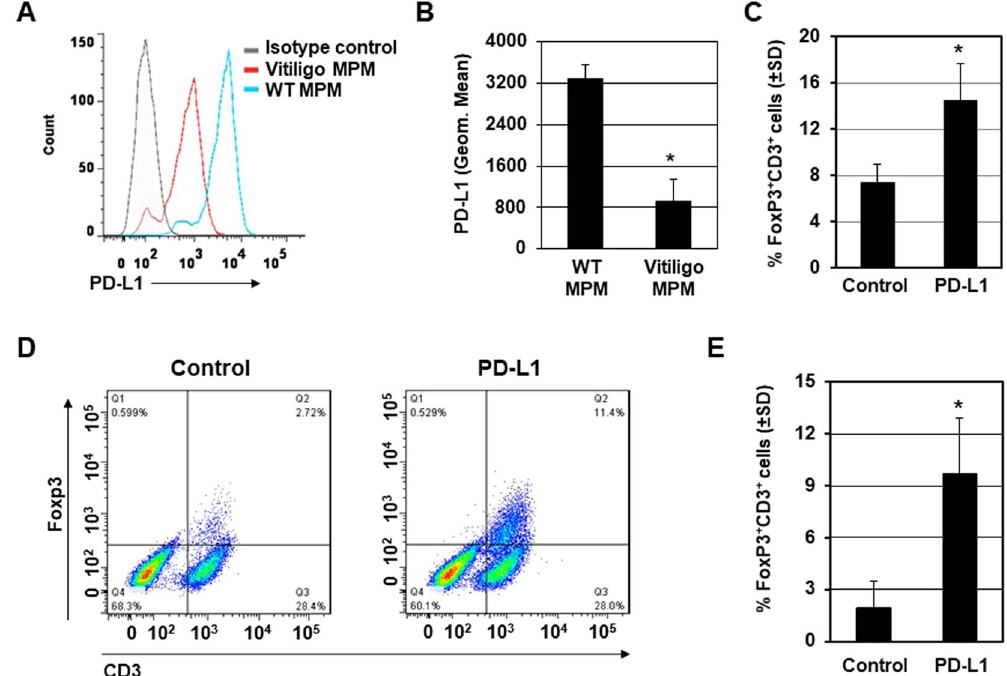
Figure 2. PD-L1 fusion protein treatment regulates T cell enrichment. ( A ) MPM were isolated from Pmel-1 mice. PD-L1 were detected by flow cytometry with specific anti-PD-L1 antibody. ( B ) Quantification of PD-L1 expression in MPM from ( A ). * p < 0.05. ( C ) Expression of FoxP3 and CD3 was evaluated by immunofluorescence staining with specific anti-FoxP3 and anti-CD3 antibodies and then quantified. ( D ) Splenocytes were isolated and assayed for Treg cell population by flow cytometry. Representative flow cytometry images of FoxP3 + CD3 + cell population were showed (Control group n = 6 cases, PD-L1 fusion protein treated group n = 6 cases). ( E ) Quantification of Treg cells population from ( C ) were shown. * p <